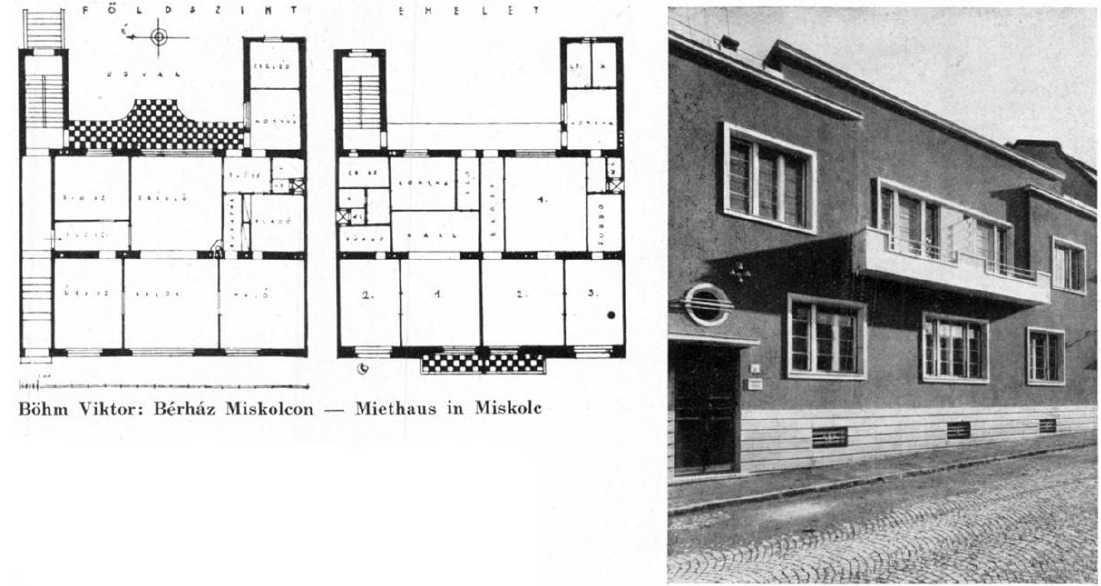
Figure 7. Layout and photograph of the 5 Csengey street. Architect: Victor Bohm, 1931. Source: ( T é r é s forma 1932a), vol. 5, no. 3, p. 80. (T é r é s Forma 1932a), vol. 5, no. 3, p.